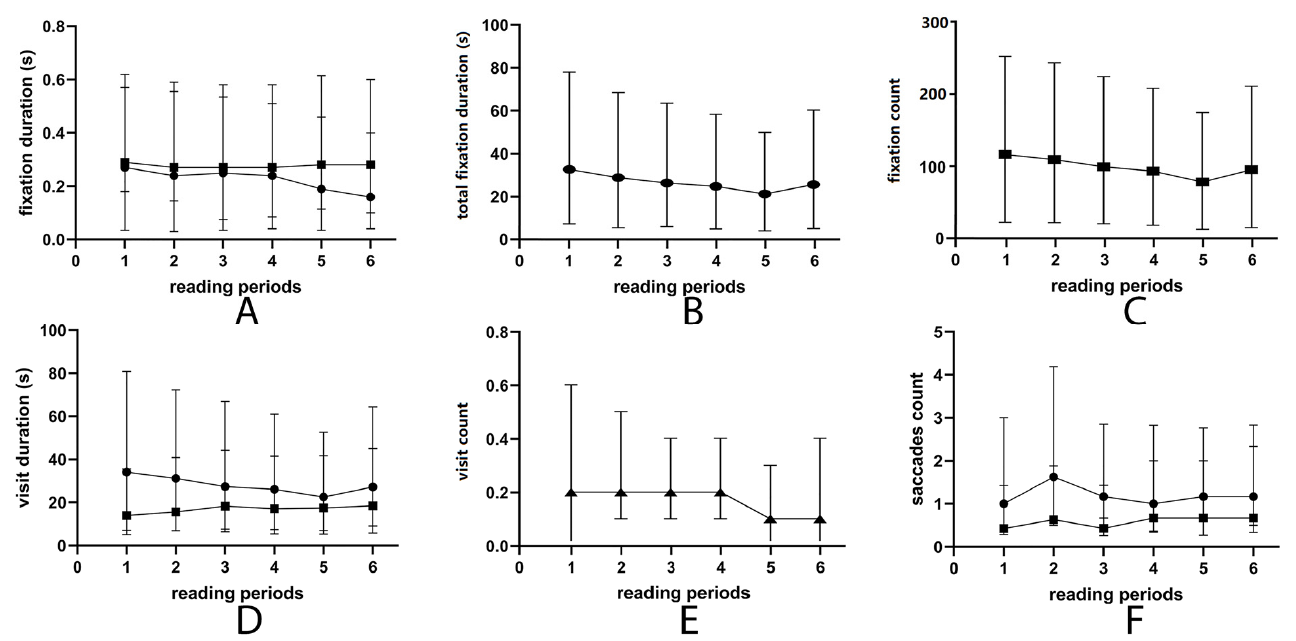
Figure 1. Changes in eye movement parameters during 6 reading periods. ( A ) First fixation duration decreased when reading time increased (dot), and first fixation duration was shorter than fixation duration mean (square) during all reading processes. ( B , C ) Total fixation duration ( B ) and fixation count ( C ) decreased during reading. ( D ) Total visit duration (dot) and visit count (triangle) decreased with time, and visit duration mean (square) increased with time. ( E ) Reading speed decreased with time, and no linear correlation was detected. ( F ) Regressive saccade (dot) increased during the second reading process and declined later. Unknown saccade (square) increased with time, but no linear correlation was found.